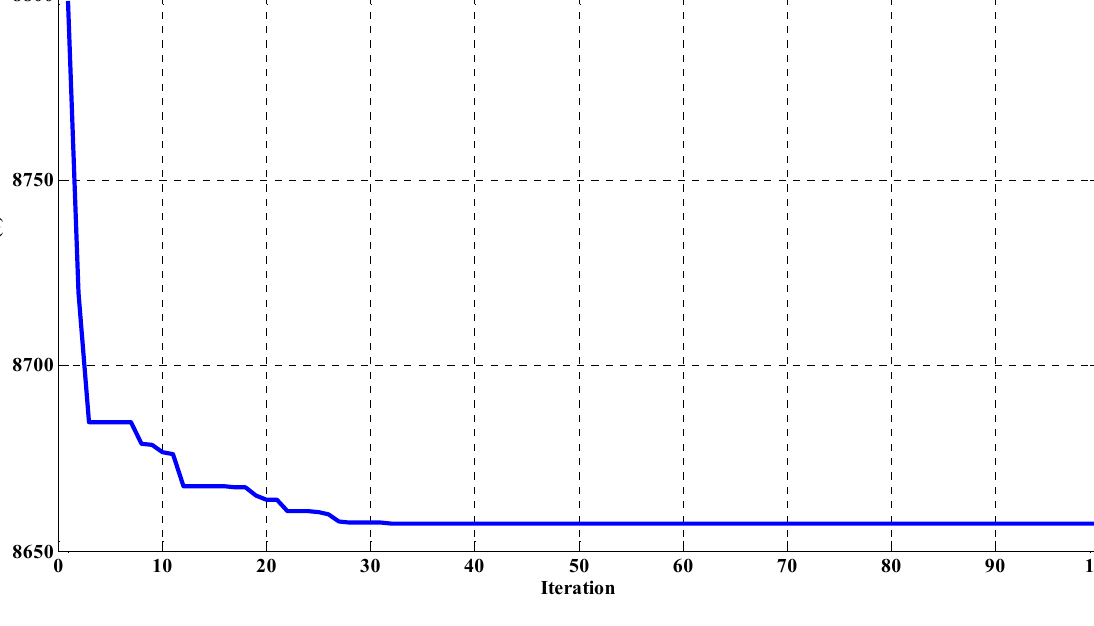
Figure 5. Convergence plot of FAMPSO for cost function considering